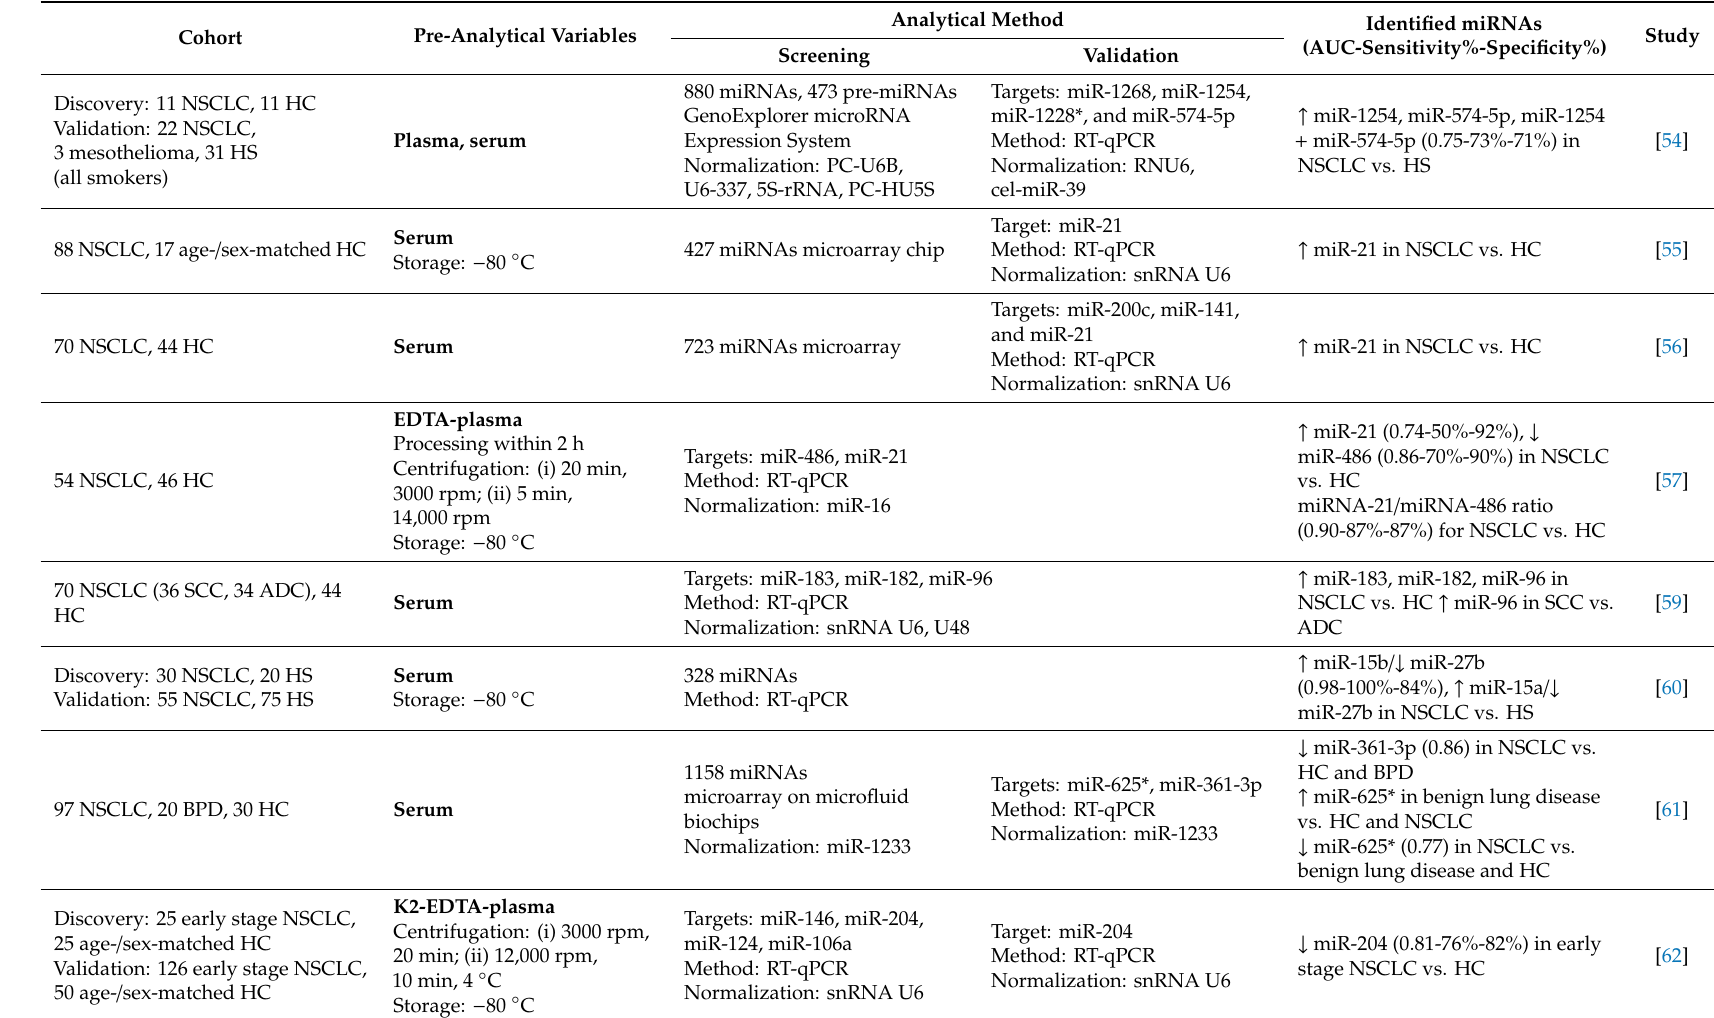
Table 1. Circulating miRNAs associated with lung cancer